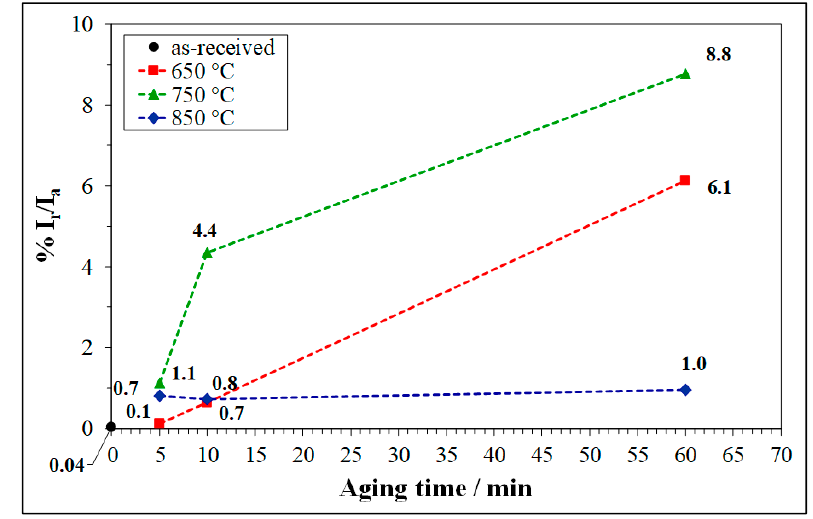
Figure 9. Optical microscopy (OM) micrographs acquired on LDSS 2404 electrodes as-received ( a ) or aged 60 min at 650 ◦ C ( b ), after DL-EPR tests in 33 wt.% H 2 SO 4 solution, at 20 ◦ C, with 0.9 wt.%